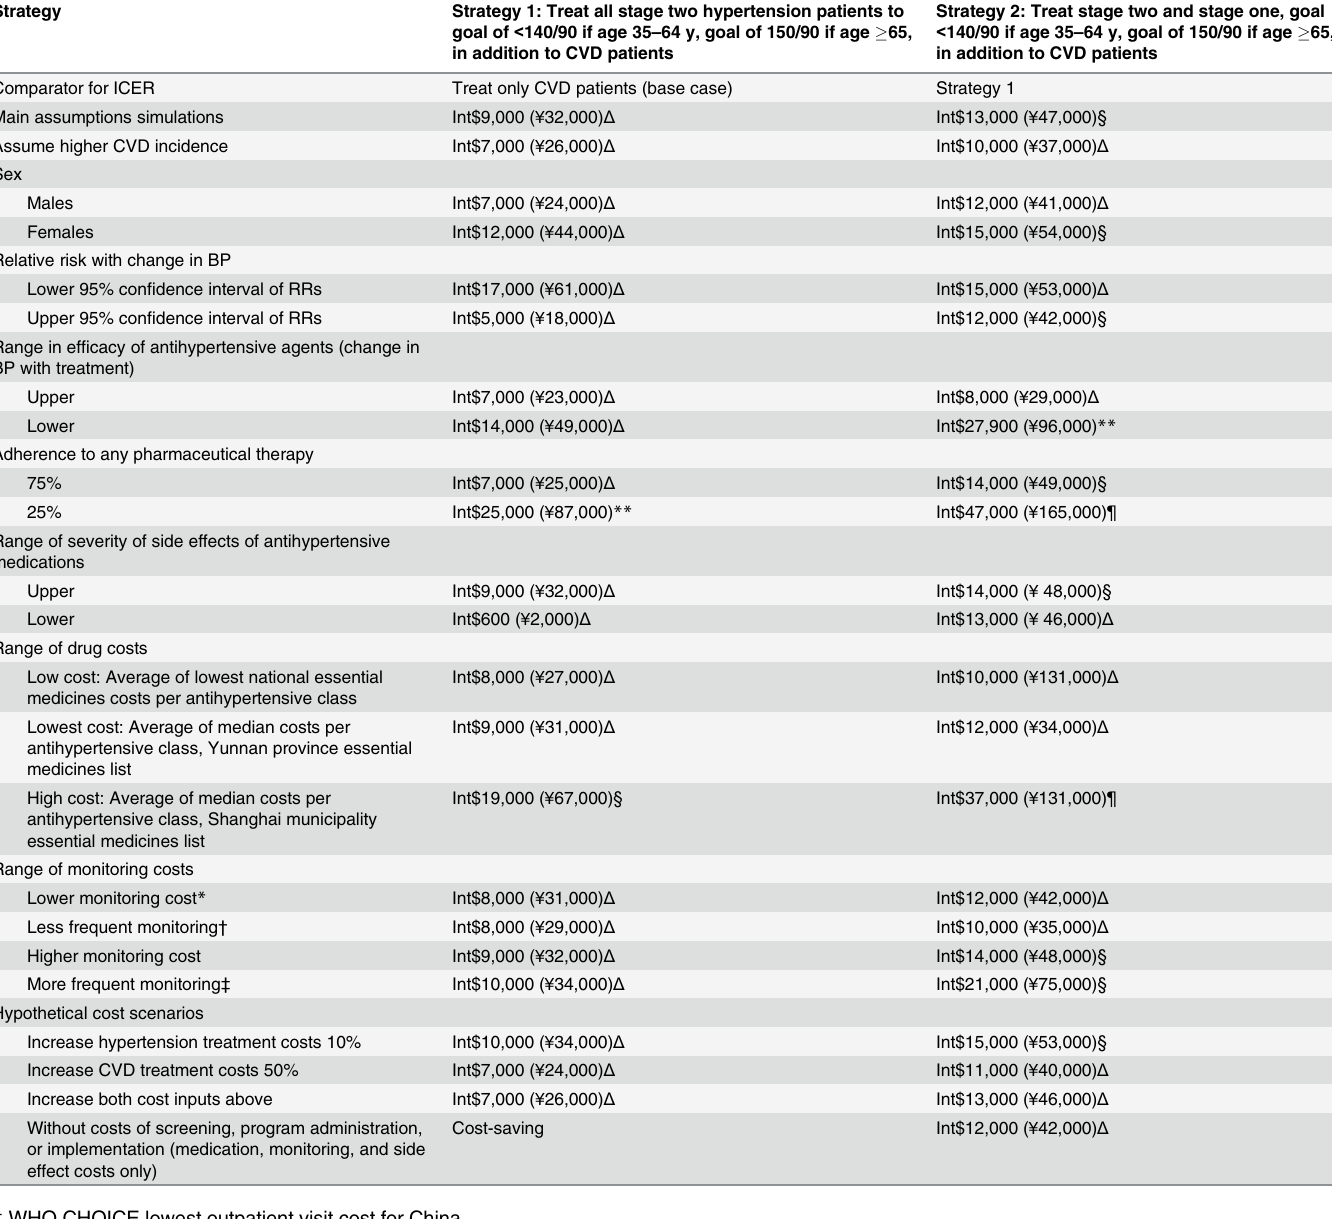
Table 3. One-way sensitivity analysis of hypertension treatment inputs. All estimates are ICERs, compared with the prior strategy. Results are in 2015 international dollars (2015 Chinese RMB). All results reported as cost saving describe strategies projected to be less costly and more effective than the prior